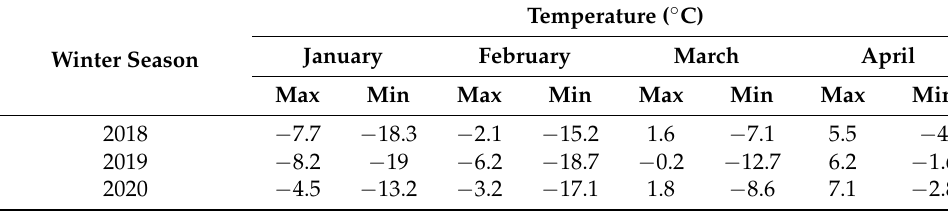
Table 1. Temperature data report for the winters of 2018, 2019, and 2020.